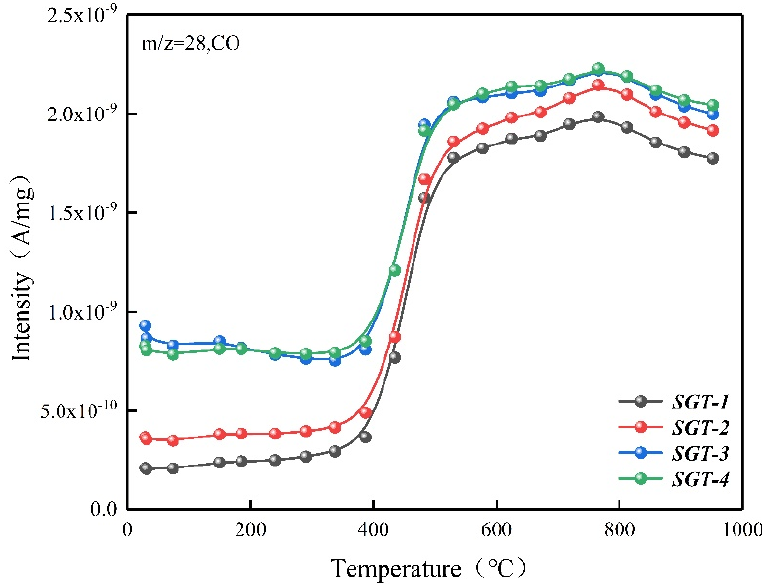
Figure 6. Evolution curves of CO.